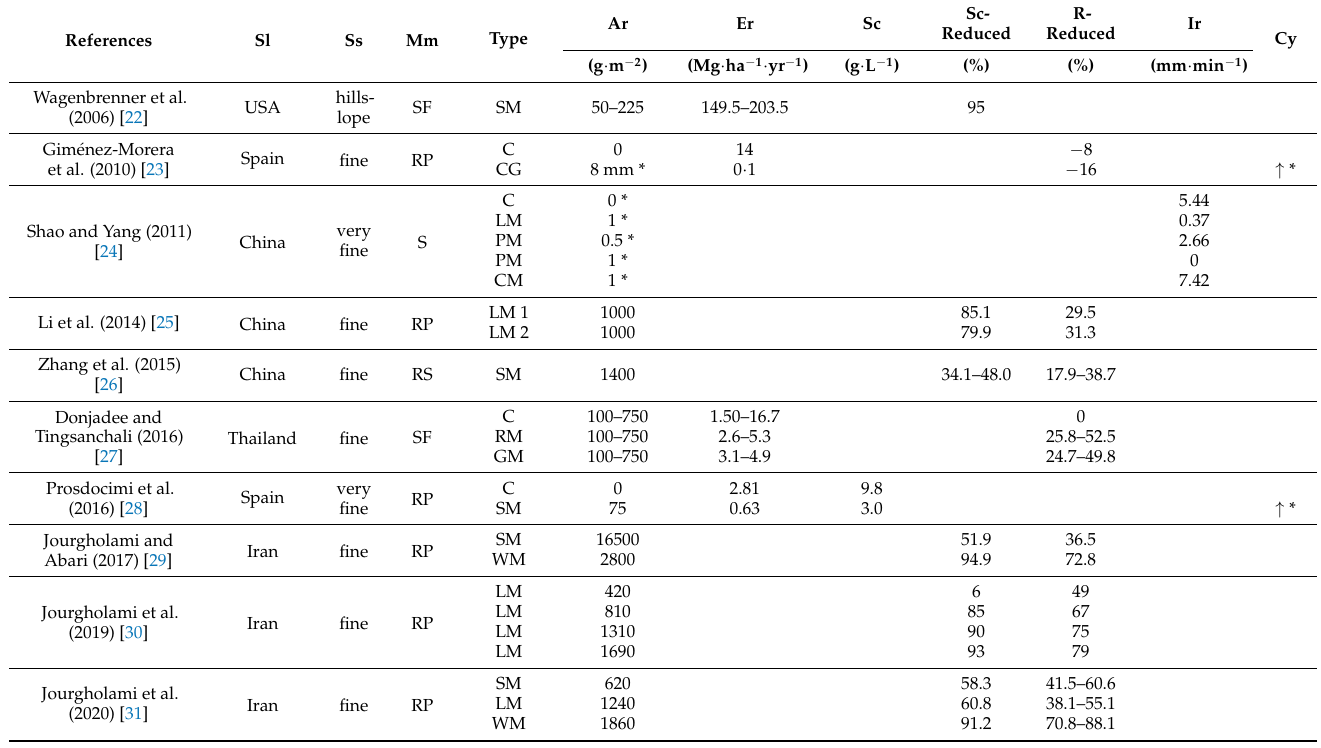
Table 2. The quantitative effects of mulching on soil erosion. We collected 12 experimental reports from the published literature of the last decade, reporting on the global practice of soil mulching in different environments. Their indicators are indicative. The listed literature relates to forest fire restoration, tillage systems in mixed forests, and potential impacts of mulch types on crop yields, surface runoff, soil erosion, etc. In which, they report: (a) spatial location (Sl), (b) spatial scale (Ss), (c) measurement method (Mm), (d) mulch type, (e) mulch application rate (Ar), (f) erosion rate (Er), (g) sediment concentration (Sc), (h) sediment concentration reduced (Sc-reduced), (i) runoff reduced (R-reduced), (j) infiltration rate (Ir), and (k) crop yield (Cy). For the Ss variable, they report: very fine (<1 m 2 ), fine (1–1000 m 2 ), hillslope (1000 m 2 − 1 ha). For the Mm variable, they report: simulation (S), rainfall simulation (RS), runoff plot (RP), and silt fence (SF). For the mulch type variable, reporting: control (C), cotton geotextiles (CG), straw mulching (SM), leaf litter mulching (LM), plastic mulching (PM), cobblestone mulching (CM), rice straw mulch (RM), grass mulching (GM), wood mulching (WM), mechanical tillage (MT), mulching with prunings + no-tillage (MP + NT). The references are reported in chronological